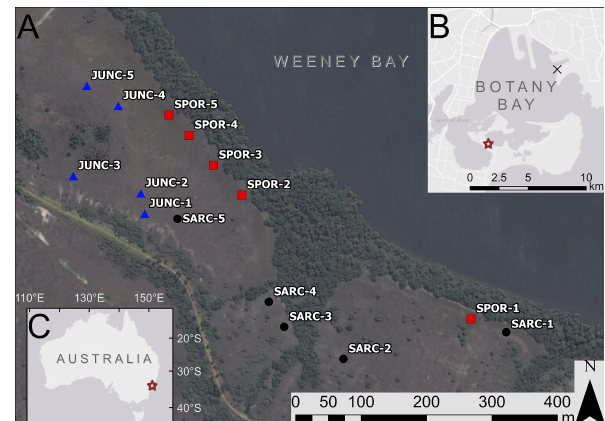
Figure 1. Location of experimental plots within Weeney Bay salt marsh of Towra Point Nature Reserve (a) , located along the southern shoreline of Botany Bay (b) in SE Aus- tralia (c) . Location of the nearest tidal gauge is marked by an X in inset B. SARC = Sarcocornia quinqueflora assemblage; SPOR = Sporobolus virginicus assemblage; JUNC = Juncus kraus- sii